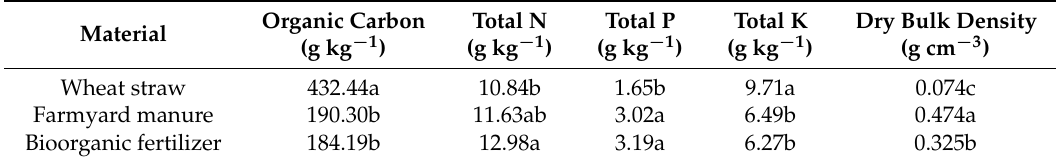
Table 2. Physico-chemical characteristics of the applied organic